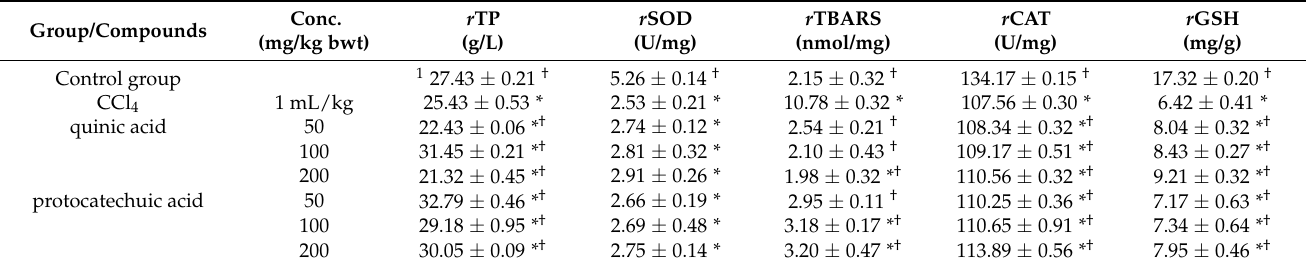
Table 3. Total protein content ( r TP), catalytic activities, and concentrations of liver antioxidant enzymes in rats exposed to different doses of compounds found in N. cataria extracts and CCl 4